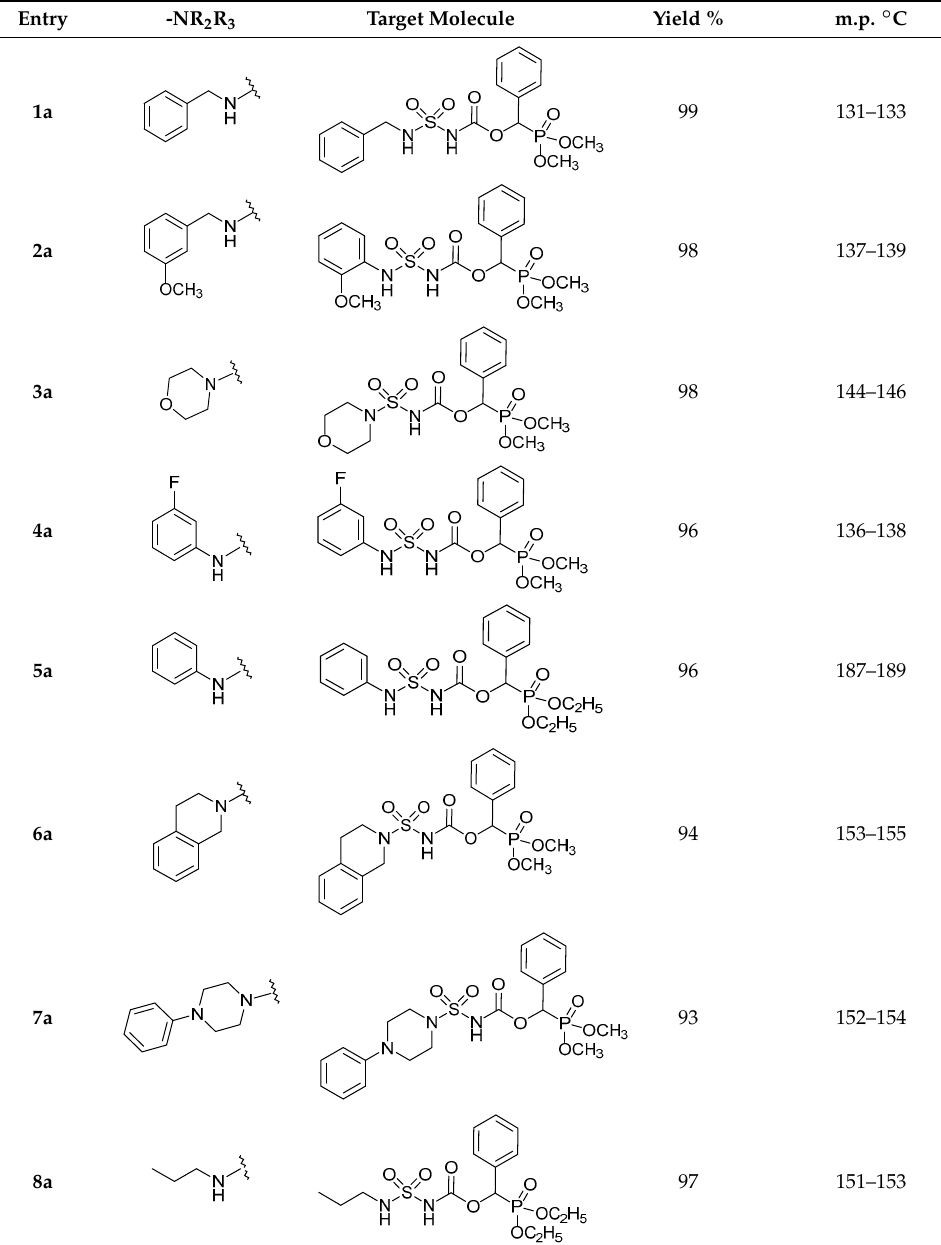
Table 1. The physical data and yields for sulfamidocarbonyloxyphosphonates 1a – 8a synthesized from primary and secondary amines.